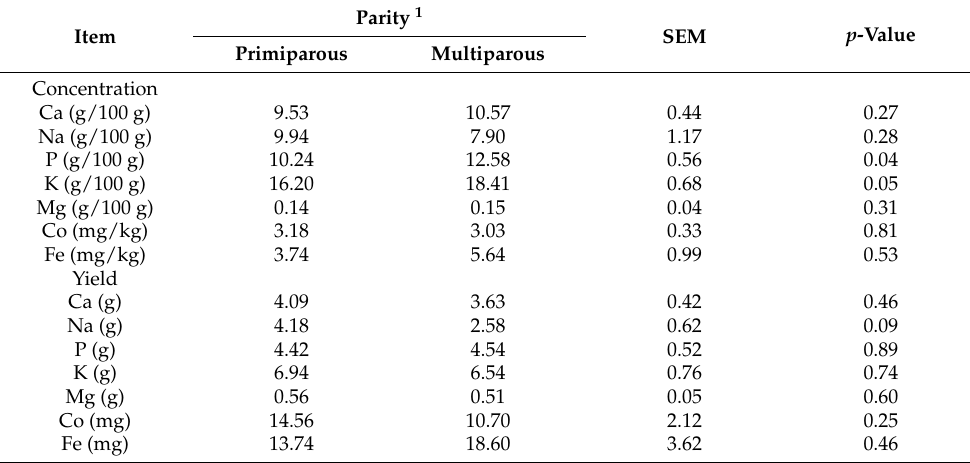
Table 5. Differences of mature milk mineral concentrations and yields between primiparous (n = 10) and multiparous (n = 10)